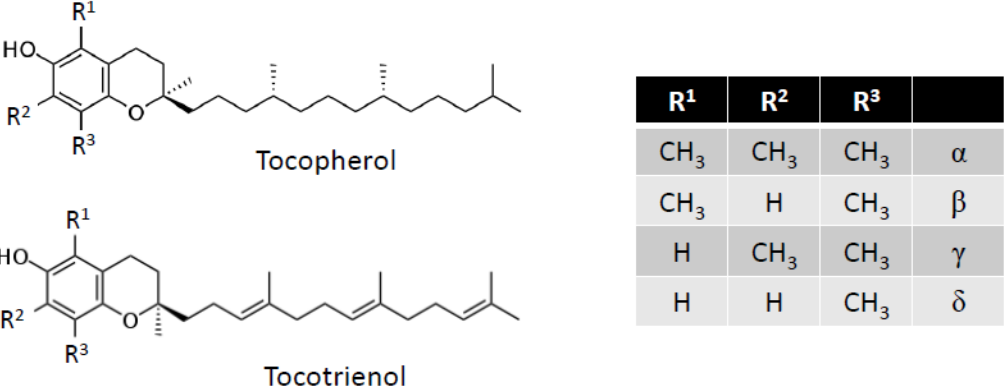
Figure 3. Vitamin E